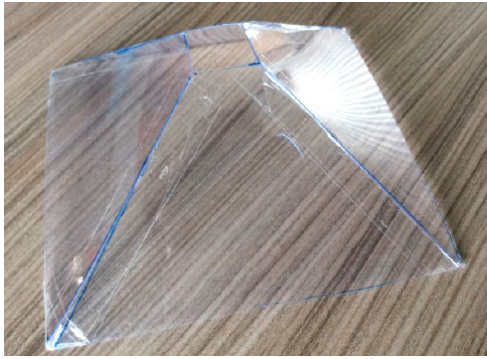
Figure 2. Image of the hologram.